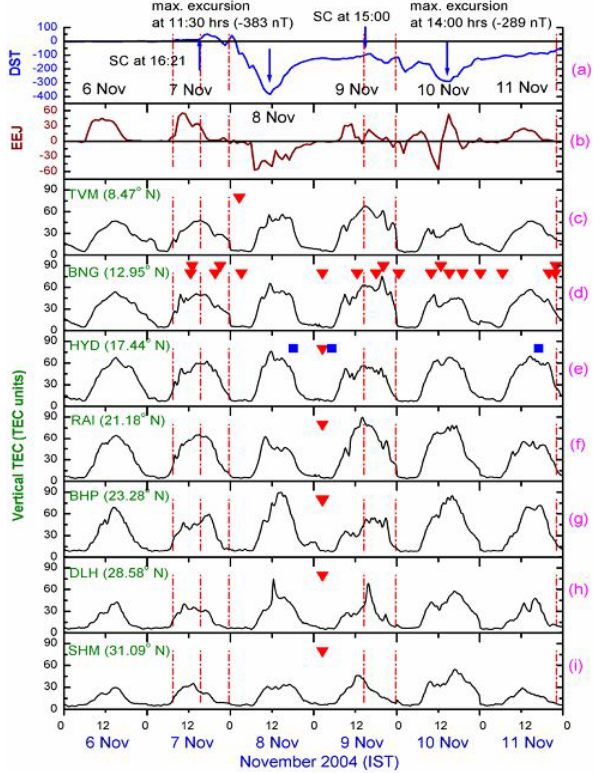
Fig. 2. Variation of TEC from a set of identified stations along the meridian of 77 ◦ E from the Indian sector, also the variation of equatorial electrojet strength along with D st index is given for the storm period of November 2004. The Red and Blue symbols indi- cate phase slips of the GPS receiver resulting in loss of lock, the accompanying phase index ( σ) and S4 index,